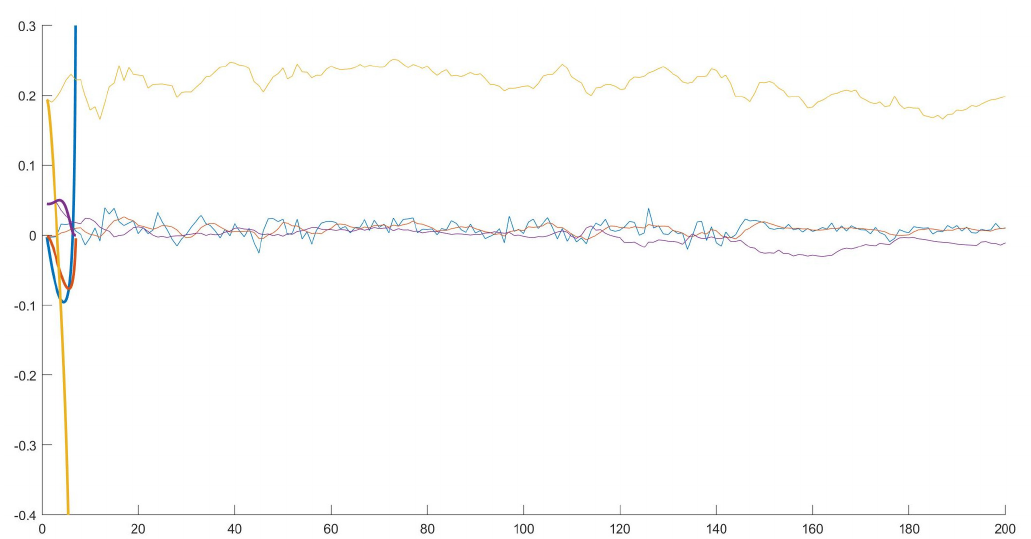
Figure 6. Time series obtained with parameters of calibration 2, that displays divergence from the long-run equilibrium. Legend: blue = rate of growth, red = expected rate of growth, yellow = share of saved income, violet: trade to income ratio. Thick line: model, normal line: